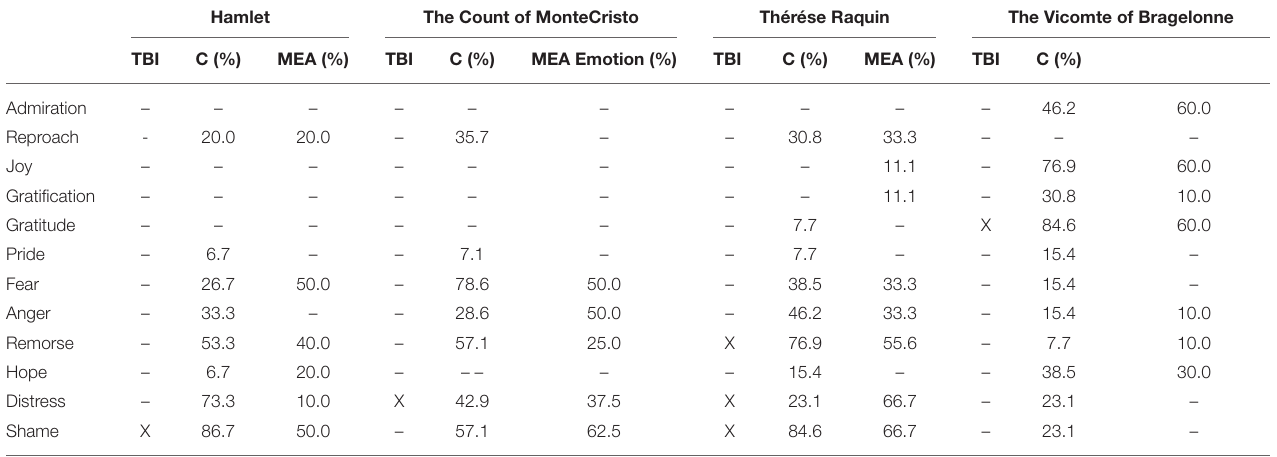
TABLE 7 | Audience studio: percentages for emotion choice (other character).